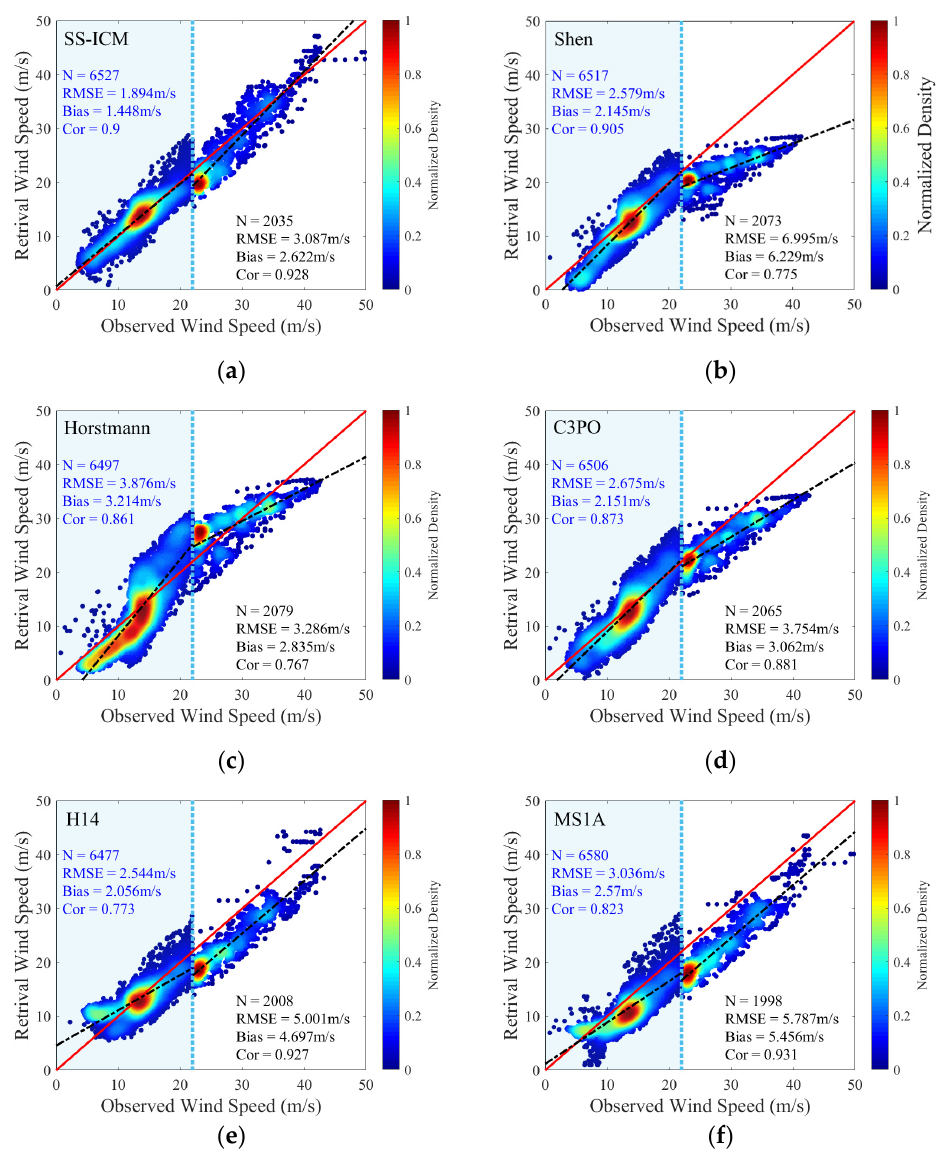
Figure 15. SAR-retrieved wind speeds (dataset B) by ( a ) the SS-ICM model; ( b ) the Shen model; ( c ) the Horstmann model; ( d ) the C3PO model; ( e ) the H14 model; ( f ) the MS1A model in vs. the ECMWF (with light blue background) and the SFMR wind speeds. Table 5. Performances of wind speeds in dataset B vs. the results retrieved by the SS-ICM, Shen, Horstmann, C3PO, H14 and MS1A models.